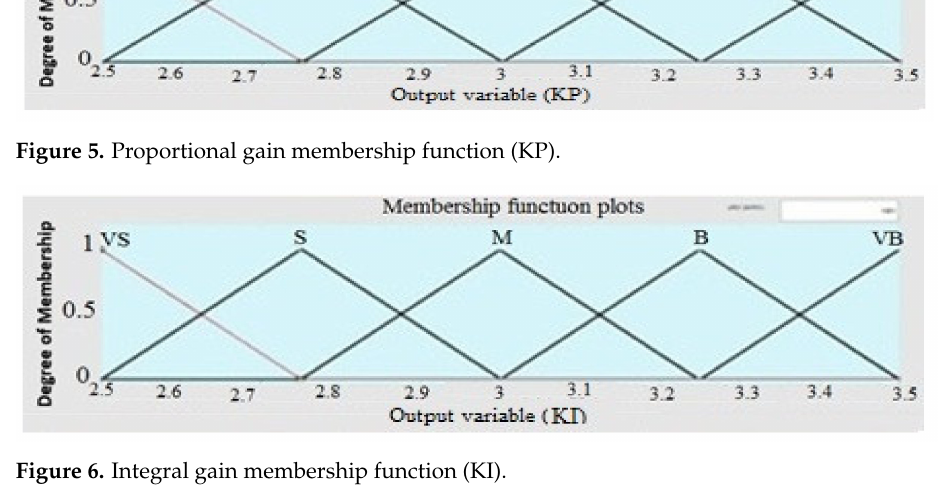
Figure 6. Integral gain membership function